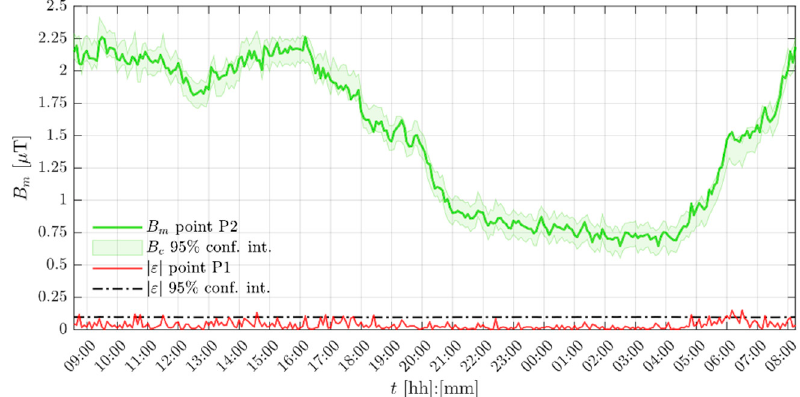
Figure 10. Position P2 measured field evolution over the 24 h (solid green like) and its predicted 95% confidence interval (filled area). The absolute value of the residuals (red trace) is well confined by the confidence interval sideband (dash-dot line).